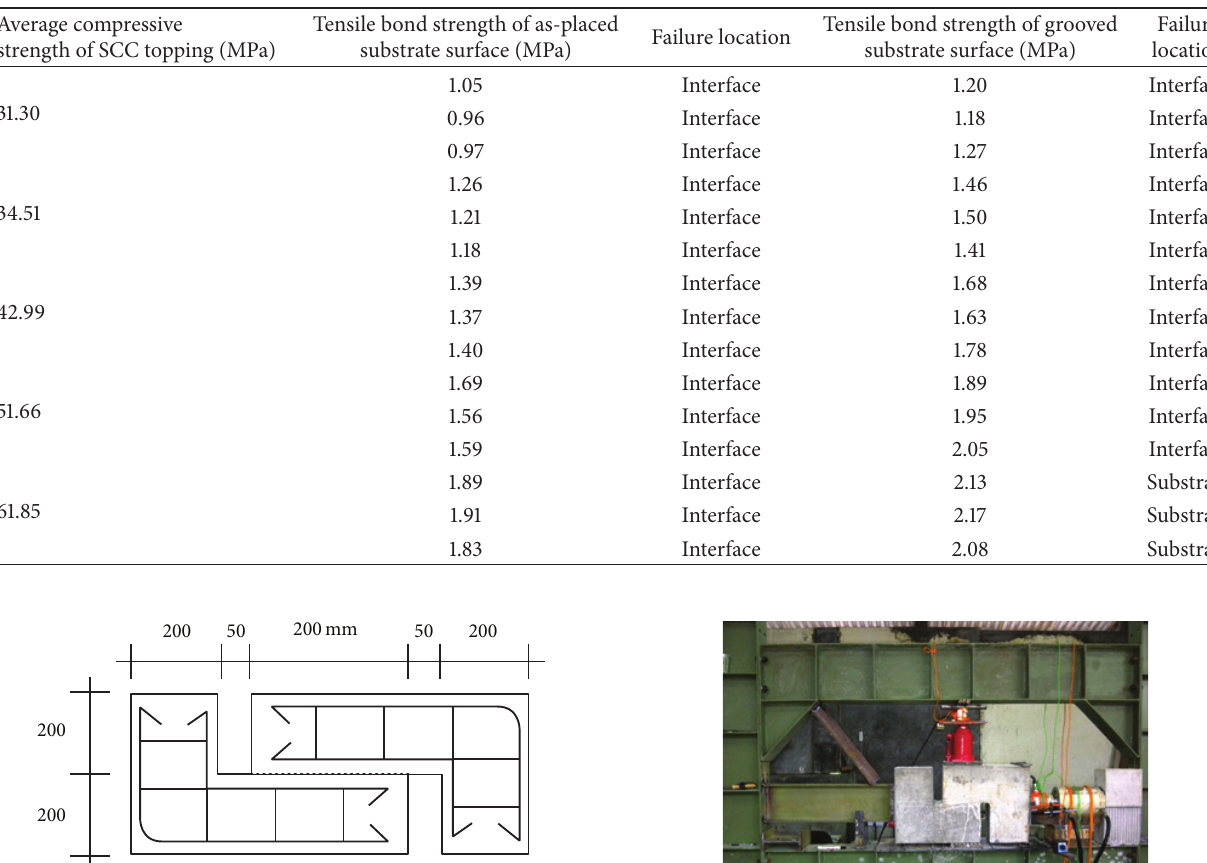
Table 4: Pull-off test results.